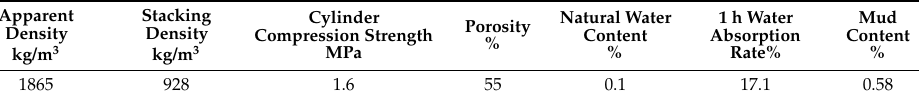
Figure 1. Fine aggregate.